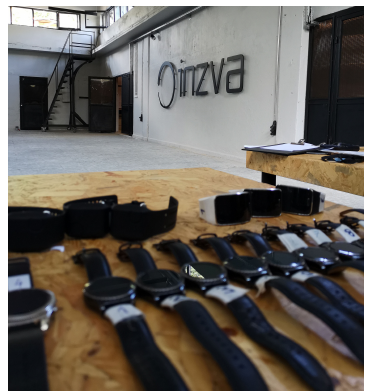
Figure 7. A view of smartwatches and wristbands after data extraction, charged and ready to use.